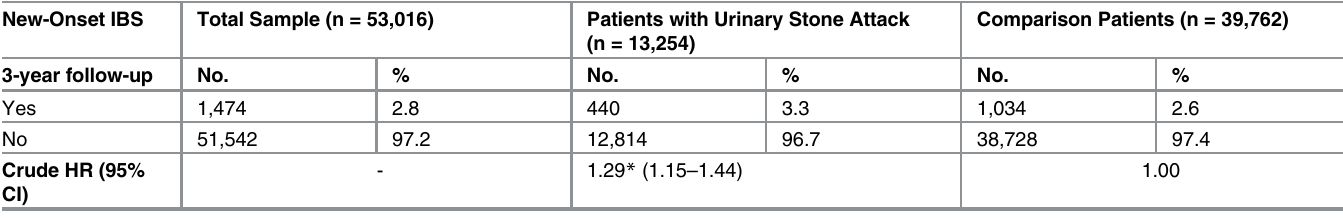
Table 2. Crude HRs for new-onset irritable bowel syndrome among patients with urinary stone attack and comparison patients. New-Onset IBS Total Sample (n =